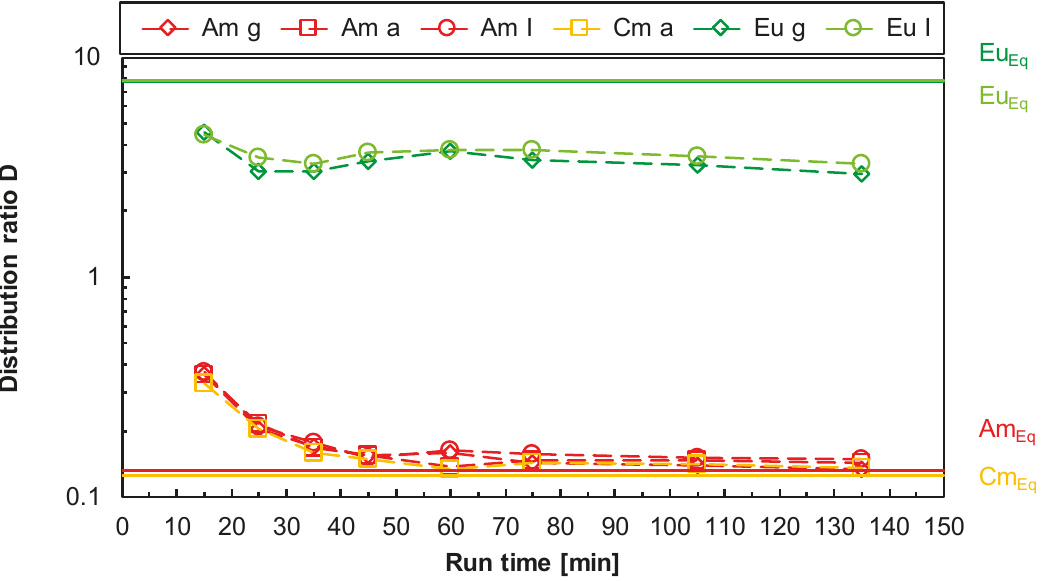
Figure 5. Am, Cm, and Eu distribution ratios as a function of the experimental run time (data points) and equilibrium values (horizontal lines) in the Ln re-extraction section single centrifugal contactor test. “g”, “a”, and “I” indicate values measured by gamma and alpha spectrometry as well as ICP-MS,